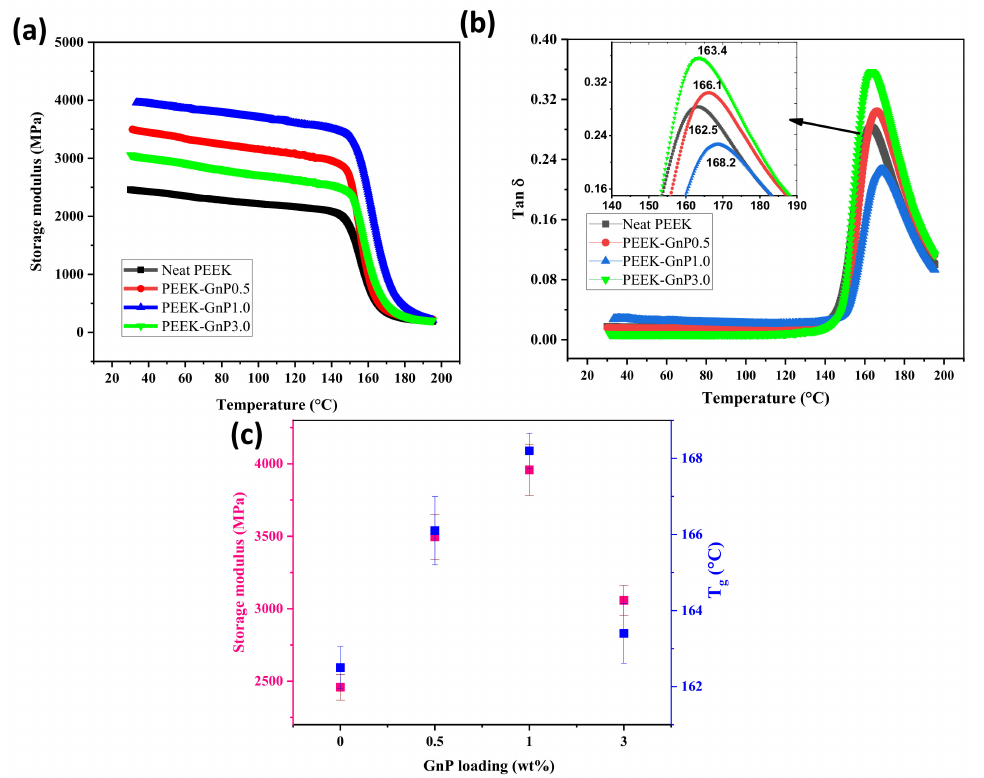
Figure 8. DMA properties of the neat PEEK and PEEK–GnP nanocomposites, ( a ) storage modulus vs. temperature, ( b ) tan δ curves and ( c ) storage modulus at 30 ◦ C and glass transition temperature ( T g ) with respect to GnP